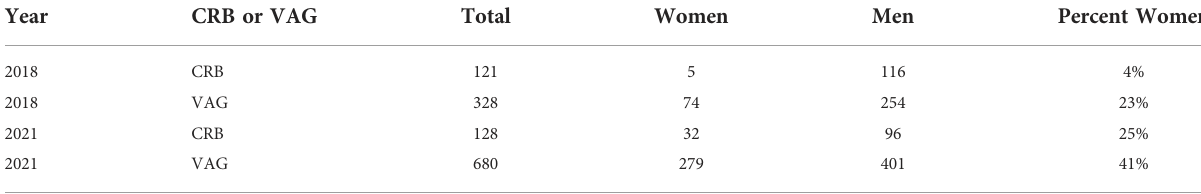
TABLE 1 Gender breakdown of CRB and VAG election